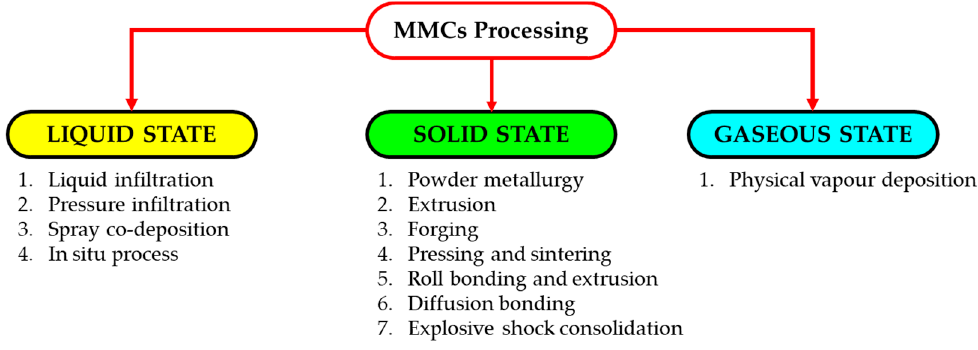
Figure 1. Metal matrix composite processing categories.